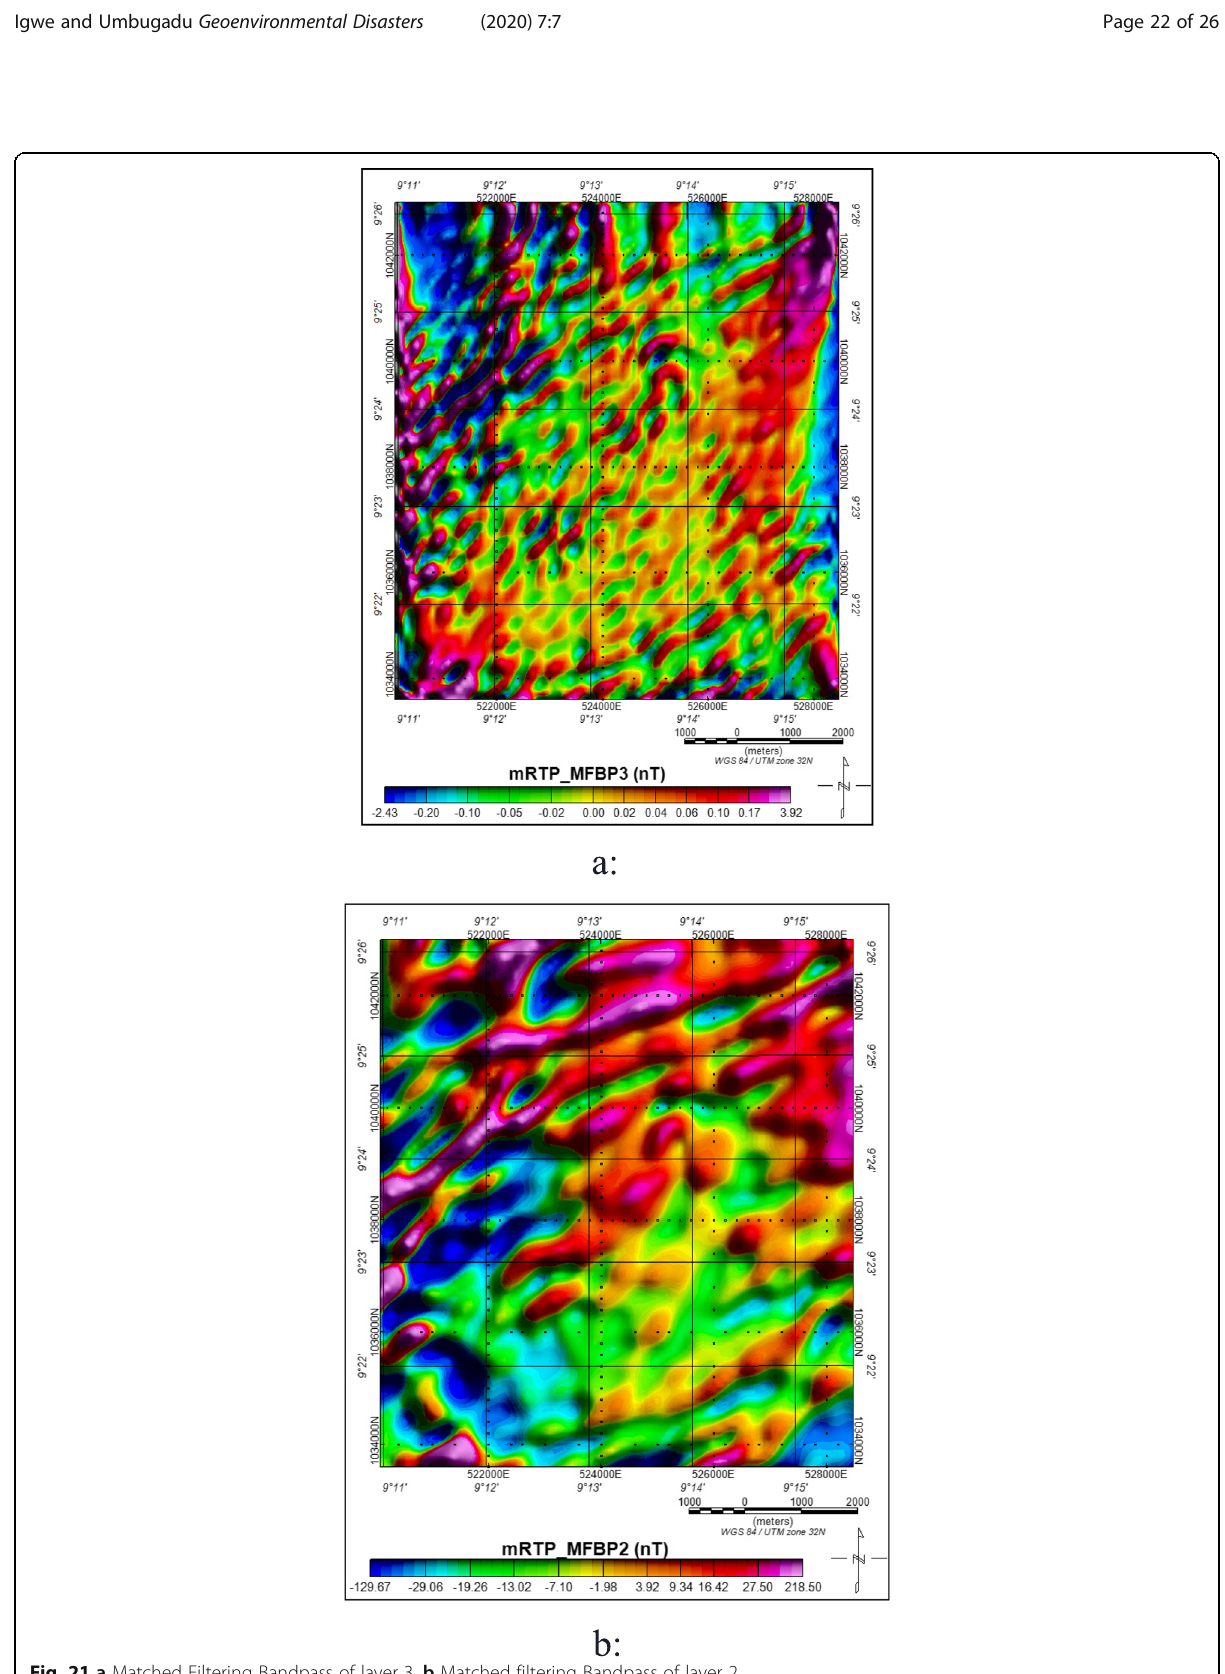
Fig. 21 a Matched Filtering Bandpass of layer 3. b Matched filtering Bandpass of layer